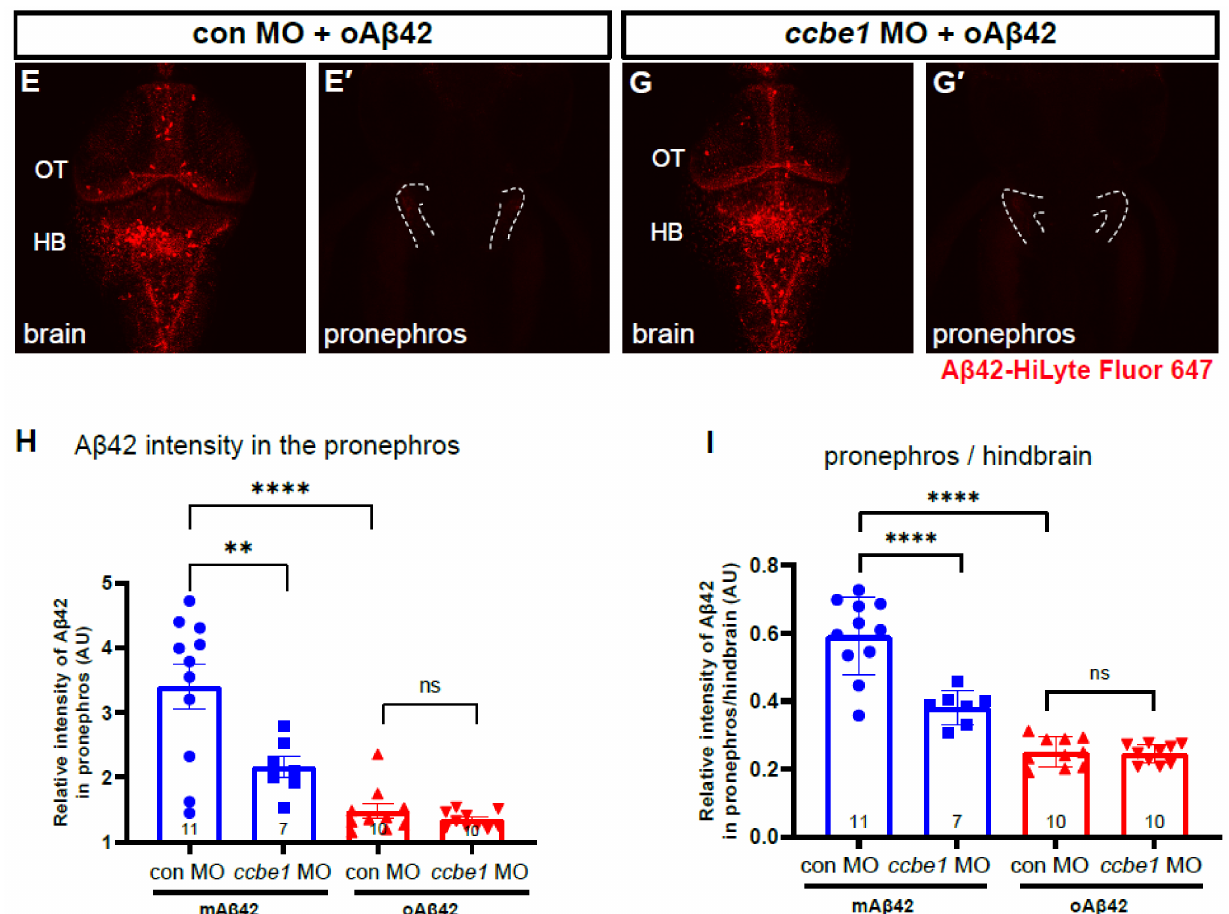
Figure 4. BLECs depletion decreases peripheral transport of mA β 42 to the pronephros. ( A ) A schematic diagram of zebrafish 3 dpf larvae with dorsal view. Dotted box depicts the loop structure of BLECs in the optic tectum. Blue lines depict the pronephros. ( B , C ) Confocal fluorescence images of the brain optic tectum region with Tg ( prox1a:TagRFP ); Tg ( fli1a:EGFP ) that labels BLECs and brain vasculatures simultaneously. Control morphant ( B ) and ccbe1 morphant ( C ) at 3 dpf with BLECs depleted in the brain with intact vasculatures. Scale bar in C = 50 µ m. ( D – G ) Dorsal view of the larval brains of control ( D , E ) and ccbe1 morphants ( F , G ) 4 h after A β 42 injection at 3 dpf. Red fluorescence represents A β 42-HiLyte Fluor 647. mA β 42 is seen in BLECs (arrowheads) in the control morphants ( D ) but not in the ccbe1 morphants ( F ). ( D (cid:48) , E (cid:48) , F (cid:48) , G (cid:48) ) Confocal images of zebrafish pronephros (dotted lines) after A β 42 (the same fish with brain images). The robust pronephric accumulation of A β 42 was detectable in mA β 42-injected control ( D (cid:48) ), but the reduced pronephric delivery of mA β 42 was observed in ccbe1 morphants ( F (cid:48) ) compared to control. oA β 42 injection into both control and ccbe1 morphants show almost no pronephric accumulation of A β 42 ( E (cid:48) , G (cid:48) ). Scale bars = 100 µ m. ( H ) Quantification of A β 42 intensity in the pronephros, normalized by the intensity of non-fluorescent background. ( I ) Quantification of the relative intensity ratio between the pronephros and hindbrain. Statistical significance was determined by ordinary one-way ANOVA with Tukey’s test. HB, hindbrain; MO, morpholino; OT, optic tectum; n , independent biological samples or animals. Numbers within bar bottom graphs represent n . **, p < 0.01; ****, p < 0.0001; ns, not